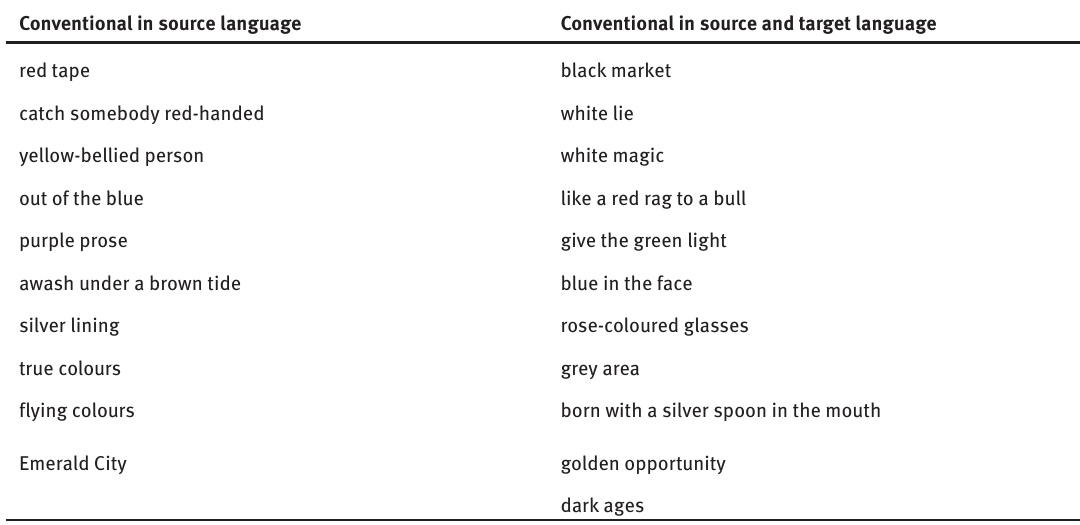
Table 1: English colour metaphors used in the translation